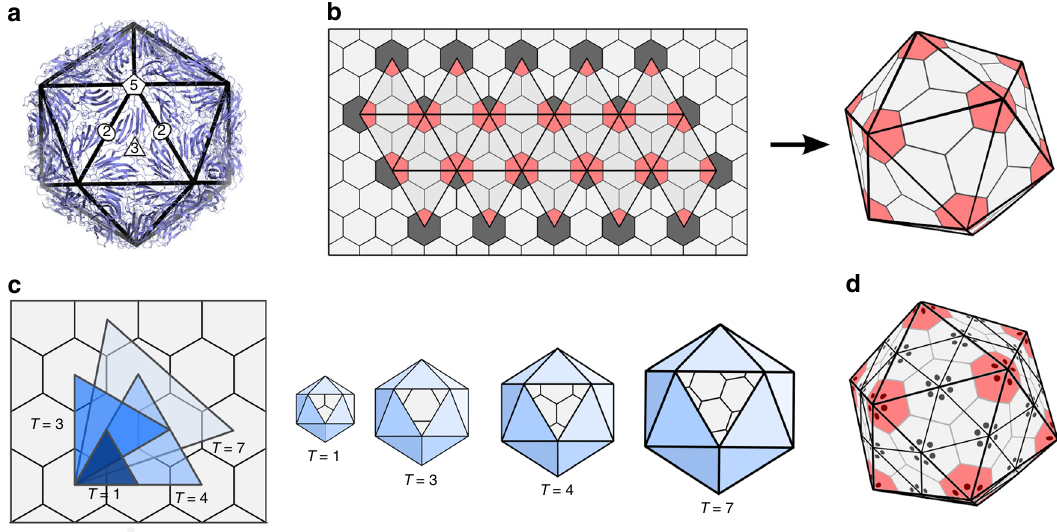
Fig. 1 Capsid architecture according to Caspar and Klug theory. a Viruses exhibit the characteristic 5-, 3- and 2-fold rotational symmetry axes of icosahedral symmetry, indicated here with reference to the vertices, edges and faces of an icosahedral frame superimposed on the crystal structure of the T ¼ 1 STNV shell ( fi gure based on PDB-ID 2BUK). b Construction of an icosahedral polyhedron via replacement of hexagons in a hexagonal lattice by the equivalent of 12 equidistant pentagons (red). Dark grey areas indicate parts of hexagons in the lattice that do not form part of the surface lattice of the fi nal polyhedral shape. c One of the 20 triangles of the icosahedral frame is shown superimposed on the hexagonal grid for the four smallest polyhedra that can be constructed in CK theory. These are shown in increasingly lighter shades of blue: T ð 1 ; 0 Þ ¼ 1, T ð 1 ; 1 Þ = 3, T ð 2 ; 0 Þ ¼ 4 and T ð 2 ; 1 Þ ¼ 7. The corresponding polyhedra (right) have 20 identical triangular faces corresponding to the triangles (left), one of which is shown in each case. d The CP positions are indicated with reference to the dual polyhedron, that is, the triangulated structure obtained by connecting midpoints of adjacent hexagons and pentagons in the surface lattice. CPs are positioned in the corners of the triangular faces (shown here as dots), and result in clusters (capsomers) of six (hexamers) and fi ve (pentamers) CPs. The example shown corresponds to a T ¼ 4 layout, formed from 240 CPs that are organised as 12 pentamers (red) and 30